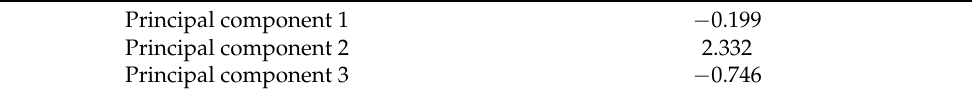
Table 6. User 32744 characterised by the three principal